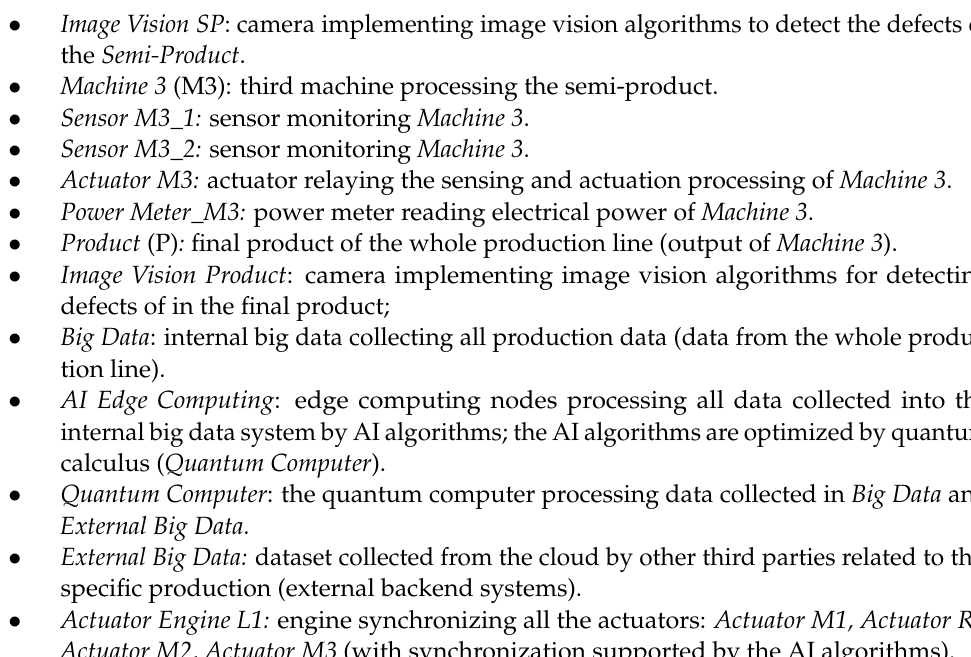
Table 6. Summary statistics concerning the parameters of the complex network of Figure 3b.